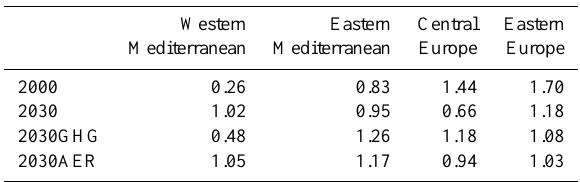
Table 2. Skewness values for the PM distributions of the four se- lected regions for each experiment. For each region and experi- ment, changes relative to all the other experiments are significant at the 95% confidence level, except for 2030-2030AER in Western